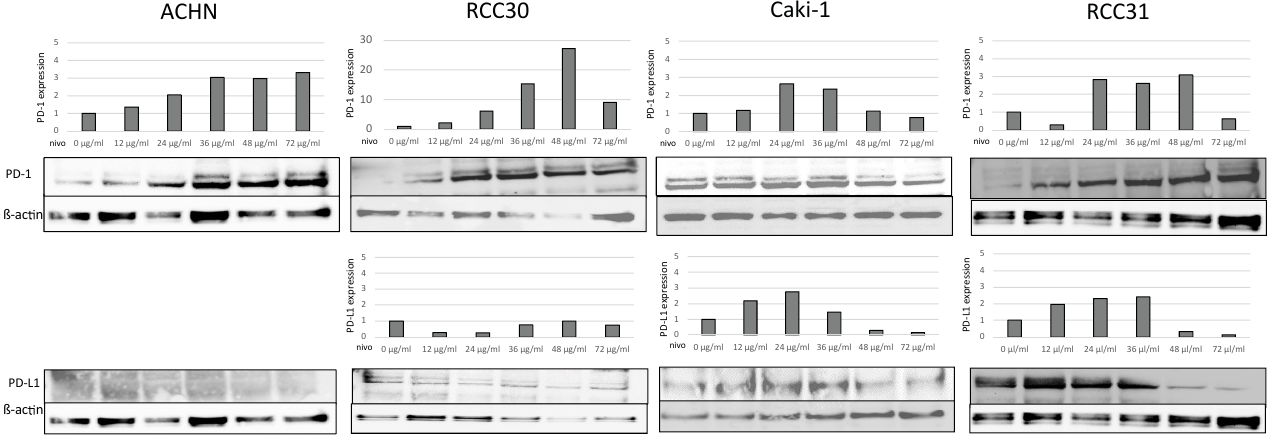
Figure 1. Expression of PD-1 and PD-L1 in renal carcinoma cell lines. Caki-1, RCC30, RCC31, but not ACHN cells, expressed PD-L1 when PD-1 was expressed in these